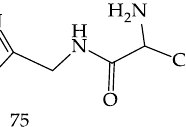
Figure 18. N-(2-Aminophenyl)-4-((5-(naphthalen-1-ylmethyl)-1,3,4-oxadiazol-2-yl)-methyl) ben- zamideas HDAC inhibitor .